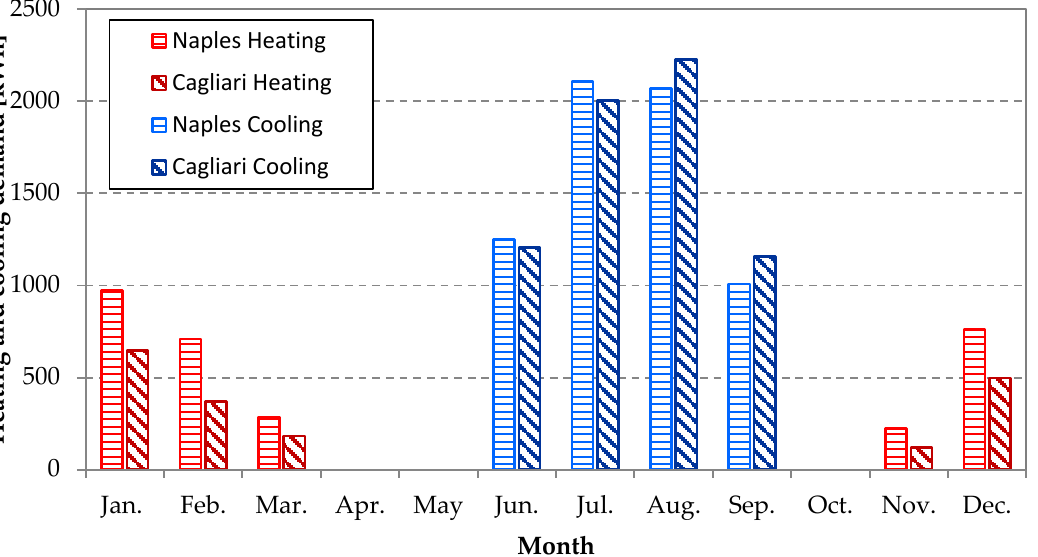
Figure 1. Monthly heating and cooling demands for Naples (horizontal striped filled column) and Cagliari (oblique striped filled column).